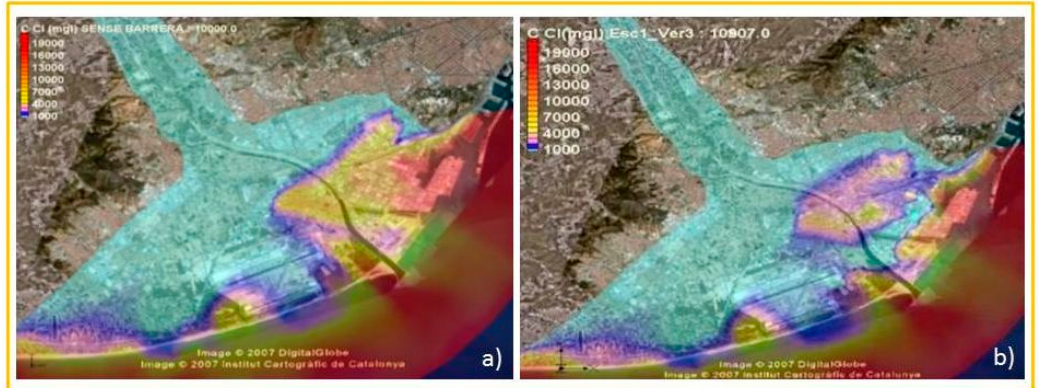
Figure 12. Intrusion barrier in the Llobregat River delta. Hydraulic barrier at Llobregat River delta. Iso-chlorides evolution graphic model for 2035 horizon: Evolution of seawater intrusion without ( a ) and with ( b ) operative recharges.